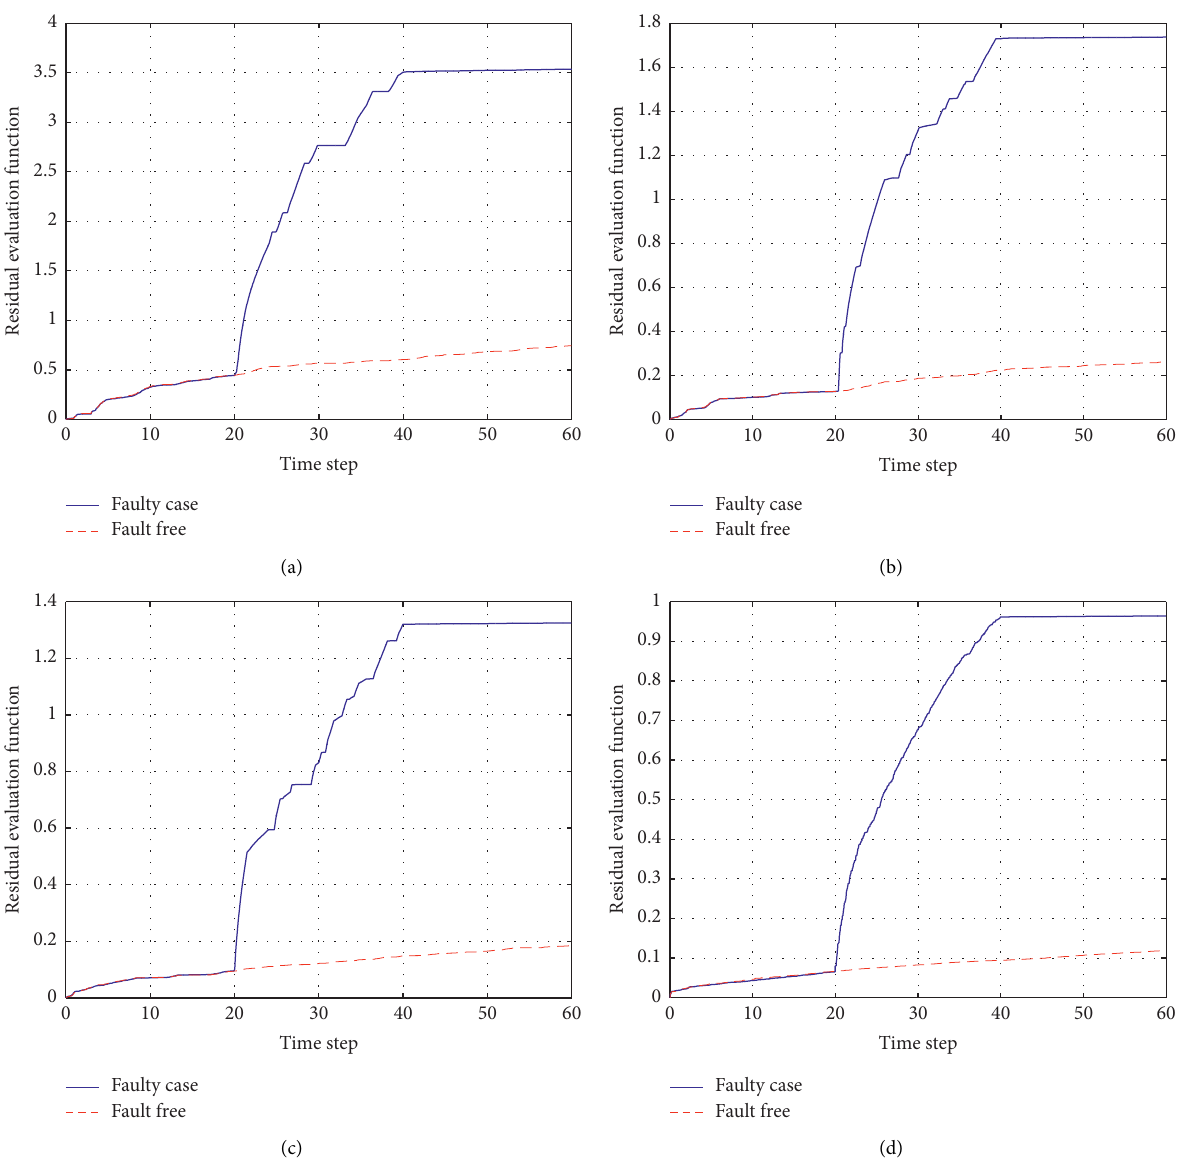
Figure 5: Residual evaluation function curves of reduced-order FDF for four different TRMs cases. (a) Case 1. TRM is completely known. (b) Case 1. TRM is polytopic uncertain. (c) TRM is partly unknown. (d) TRM is completely